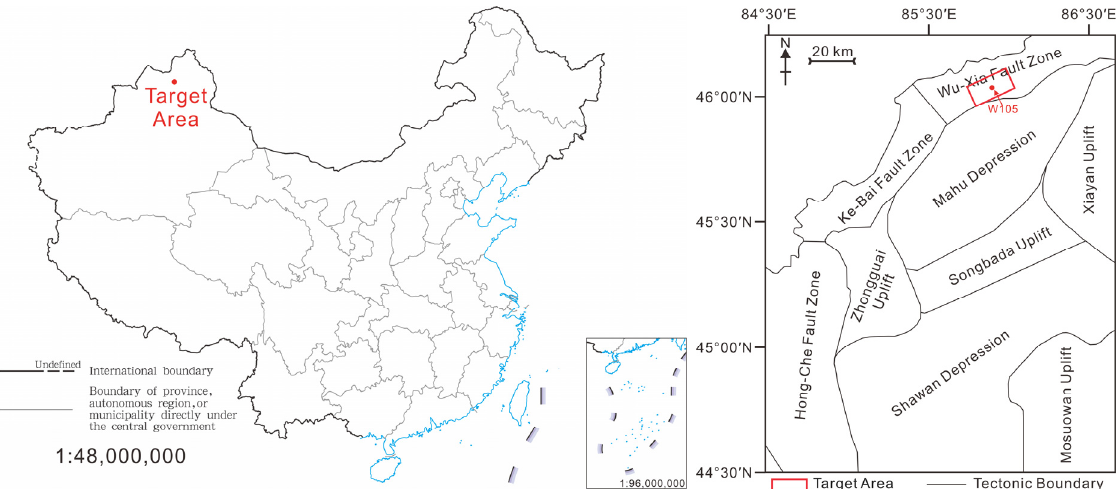
Figure 1. Structural and geographic location map of the study area.